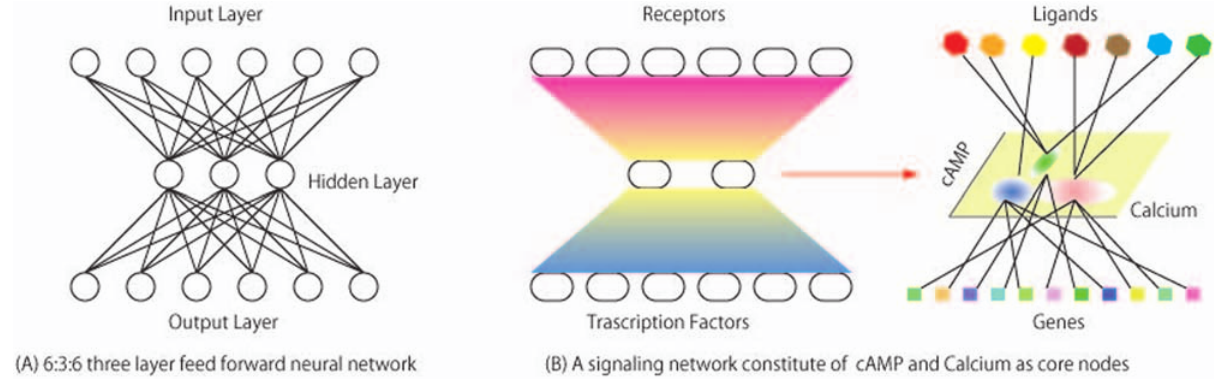
Figure 1. Bow-tie network for signaling. Bow-tie networks generally have diverse inputs and outputs with conserved core nodes. It is called ‘‘bow-tie’’ as its pictorial representation resembles bowtie. Fig 1(a): In a three layer feed forward neural networks, a hidden layer (a middle layer) provides generalization capability and the neural network can function as classifier of diverse inputs mapping into diverse output patterns. It is essential that numbers of nodes in the hidden layer is smaller than numbers of nodes in inputs and output layers in order to achieve high level of generalization. This is an example of 6:3:6 feed forward network with 6 input nodes, 3 hidden nodes, and 6 output layer nodes. Fig 1(b): In signaling networks, receptors corresponds nodes in an input layer, molecules such as cAMP and calcium corresponds nodes in a hidden layer, and transcription factors corresponds to nodes in an output layer (Left). Looking at this from a stimuli-response viewpoint, it shall be viewed as a process that diverse ligands activate variety of receptors forming distinct activation patterns and results in patterns of activations at transcriptional level (Right). An intermediate layer (core nodes) that corresponds to the hidden layer in the feed forward neural network shall provide generalization capability to the signaling network. In GPCR pathway, cAMP and calcium are key molecules constituting this layer. Thus, diverse stimuli are classified into several groups that have similar calcium and cAMP elevation. Ligands that are classified into the same group shall activate similar subset of genes, hence invoking similar physiological responses, if generalization is actually taking